Question: How would you classify this visualization?
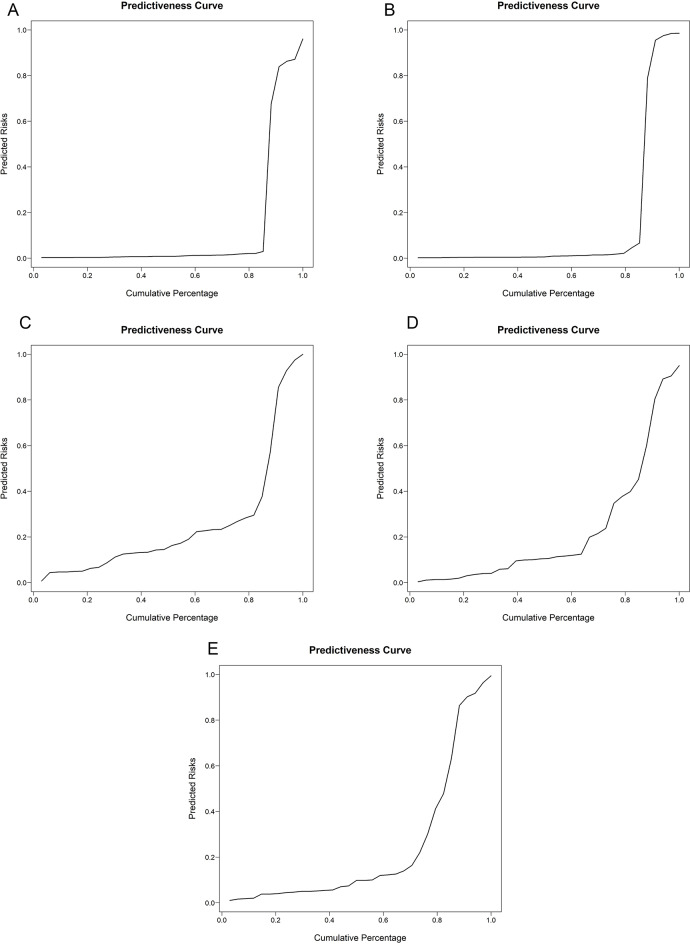
Answer: line